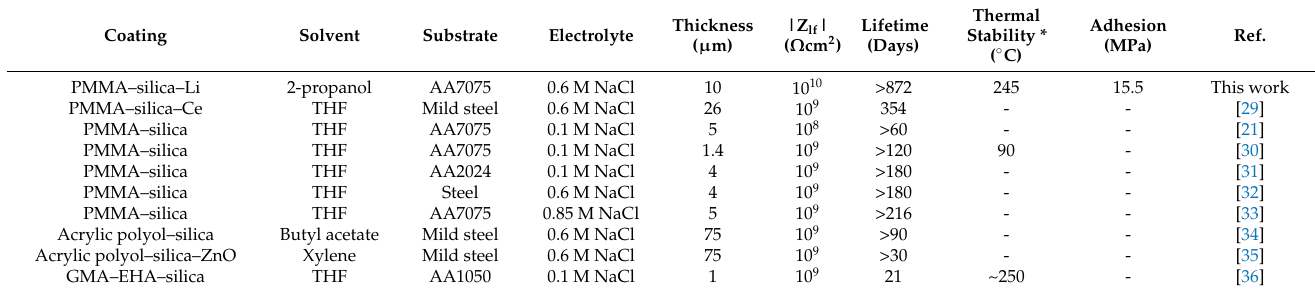
Table 2. Reported properties of PMMA–silica coatings for anti-corrosion